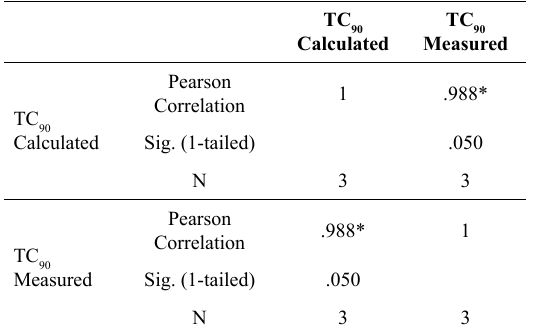
Table 12. Statistical results of comparison of experimental and calculated CRI using aging